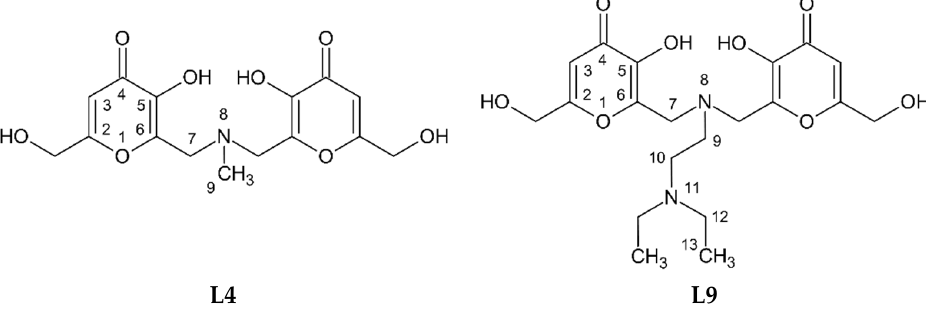
Figure 1. Molecular structure of L4 and L9 ligands.